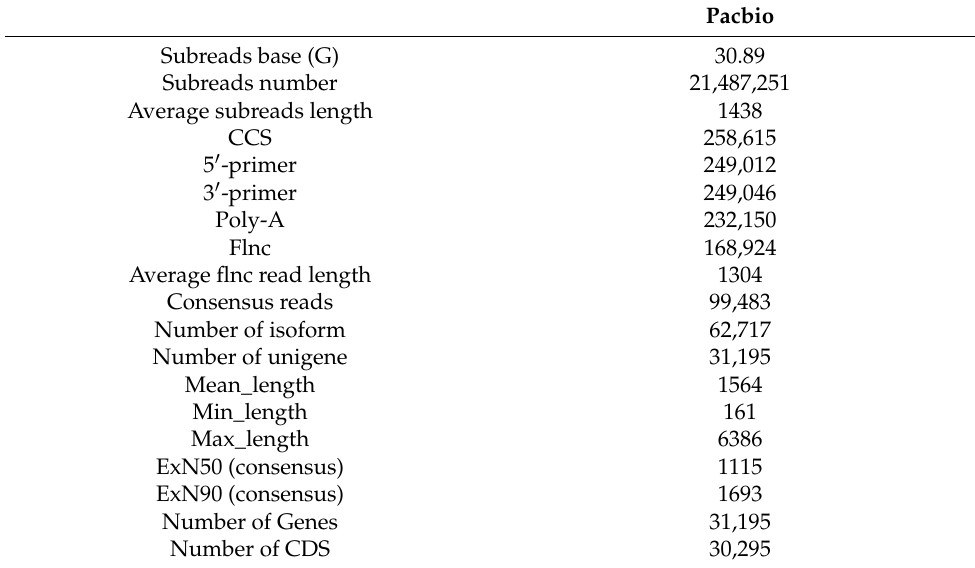
Table 1. Summary for the transcriptome data of I. lactea var. chinensis using